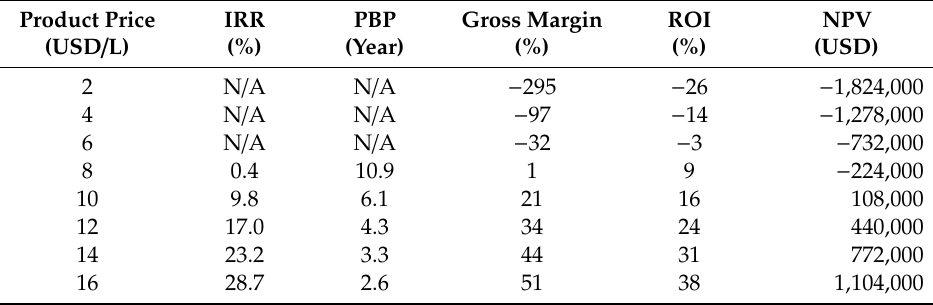
Table 7. E ff ect of hand sanitiser price on some economic parameters in this